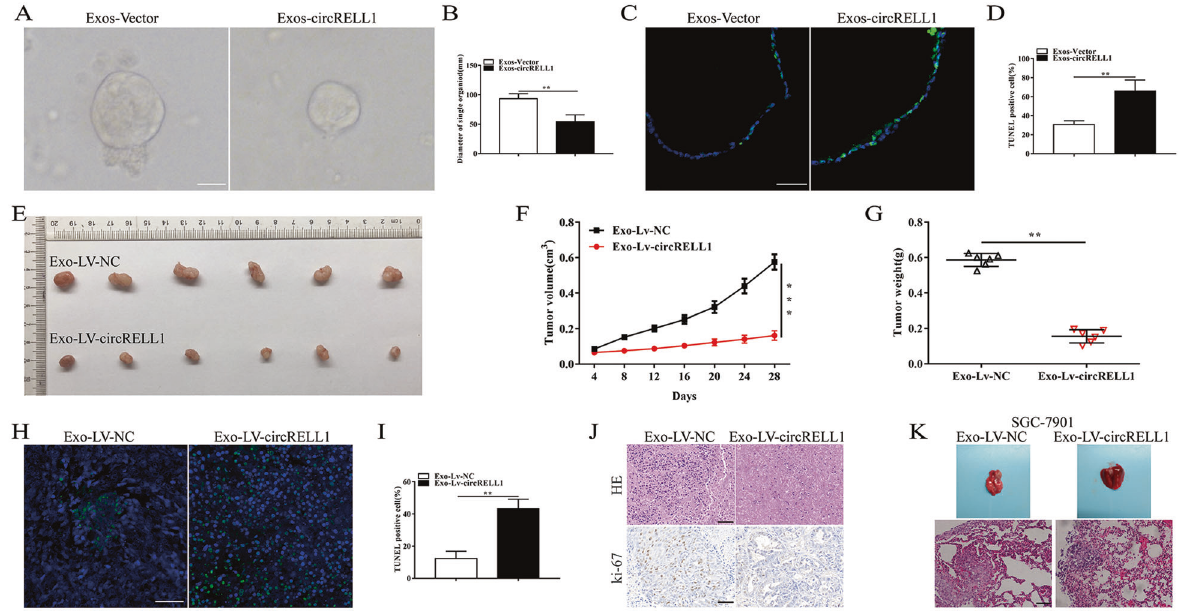
Fig. 4 Exomsomal circRELL1 decreases GC organoids proliferation and inhibits tumor growth, and metastasis in vivo. A , B Representative results of human GC organoids culture after co-culturation with circRELL1-overexpressing exosomes or control exosomes (scale bar: 25 μ m). C , D Assessment of the apoptosis of organoids cocultured with exos-circRELL1 or exos-Vector by TUNEL assays. E SGC-7901 transfected with Exo-LV-circRELL1 or Exo-LV-NC was inoculated in the burden nude mice. F , G Analysis of tumor size and weight after different treatments. H , I Assessment of the apoptosis of the xenografts by TUNEL assays (scale bar: 50 μ m). J Representative results of HE staining of the specimen and assessment of the Ki-67 protein levels in the xenografts by IHC analysis (scale bar: 50 μ m). K Representative images of pulmonary metastasis and HE staining of specimen (scale bar: 50 μ m). Results are presented as mean ± SD of three independent experiments. ** P < 0.01, *** P < 0.001.